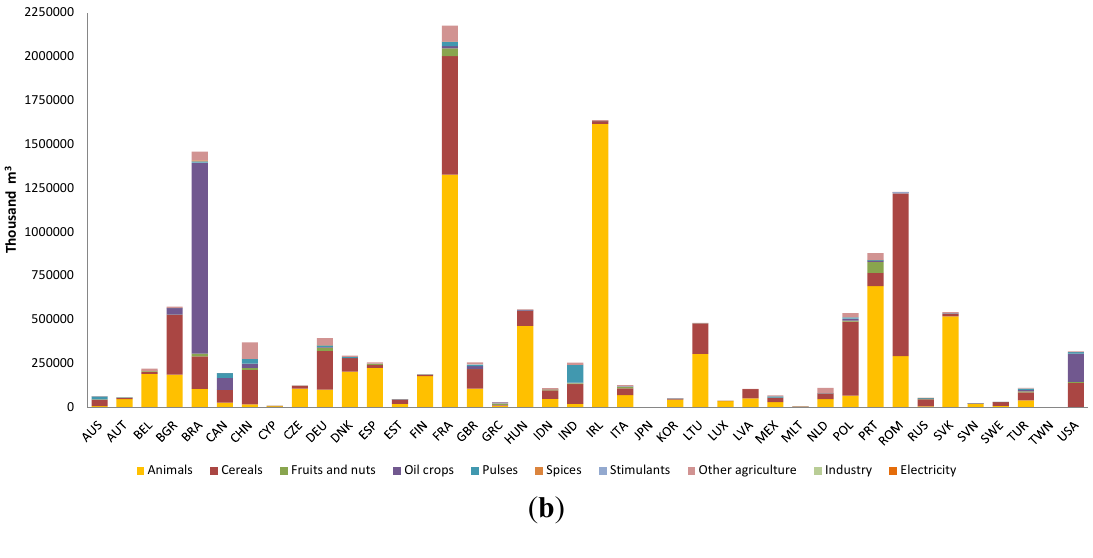
Figure 3. Green virtual water imports of the food sector by country and sector in 1995 ( a ) and 2009 ( b ), thousand m 3